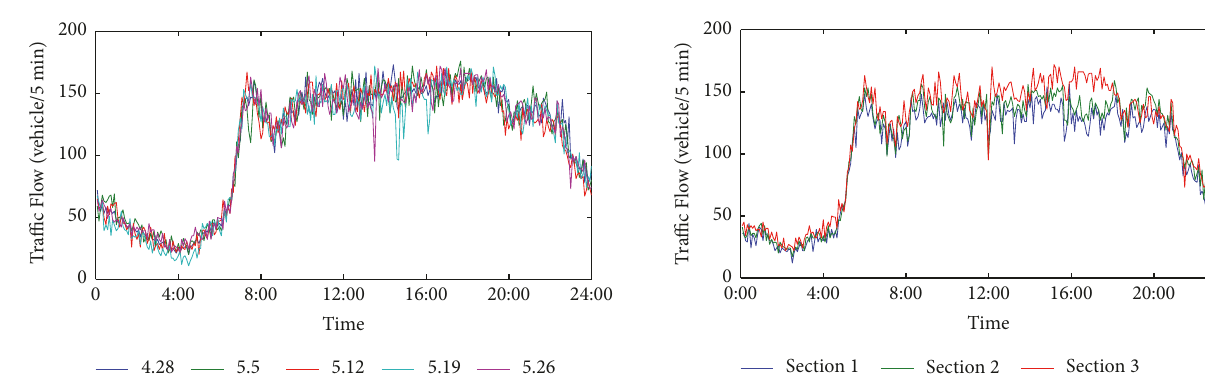
Figure 5: Traffic flow data of the same detector for five consecutive Monday.